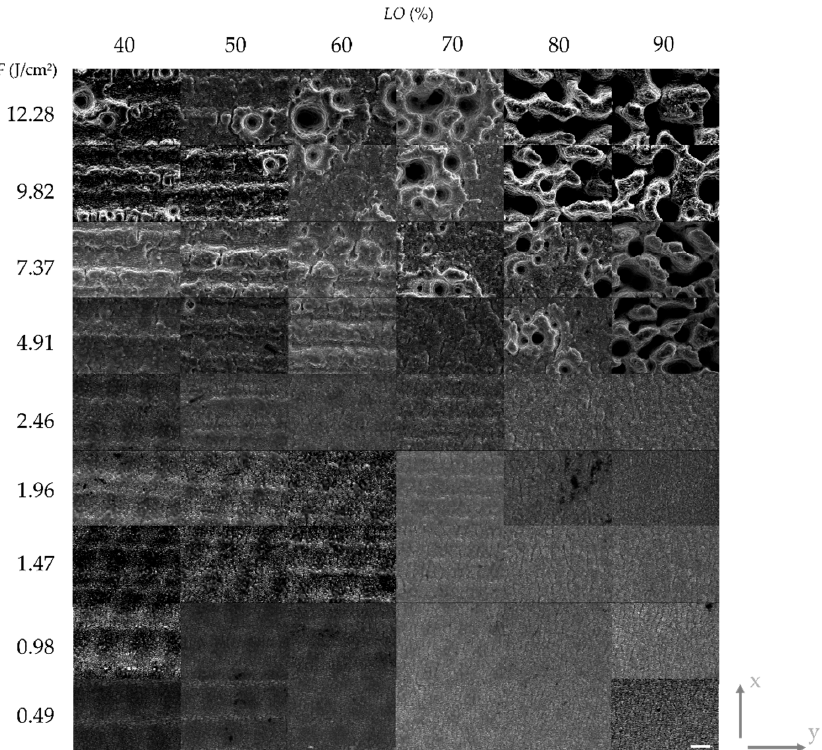
Figure 4. Structured Ti6Al4V surfaces with varied fluence F and scanning line overlap LO in a matrix of SEM images. The y-axis indicates the scanning direction for the PO. The x-axis indicates the line feed direction for the LO . Formation of microstructures can be observed at a F of approx. 4.91 J/cm² and higher. With an increasing LO , a more homogeneous surface with smoother trench formation is apparent (confirmed by elevation height profiles in Figure 6). Scale bar: 10 µm.